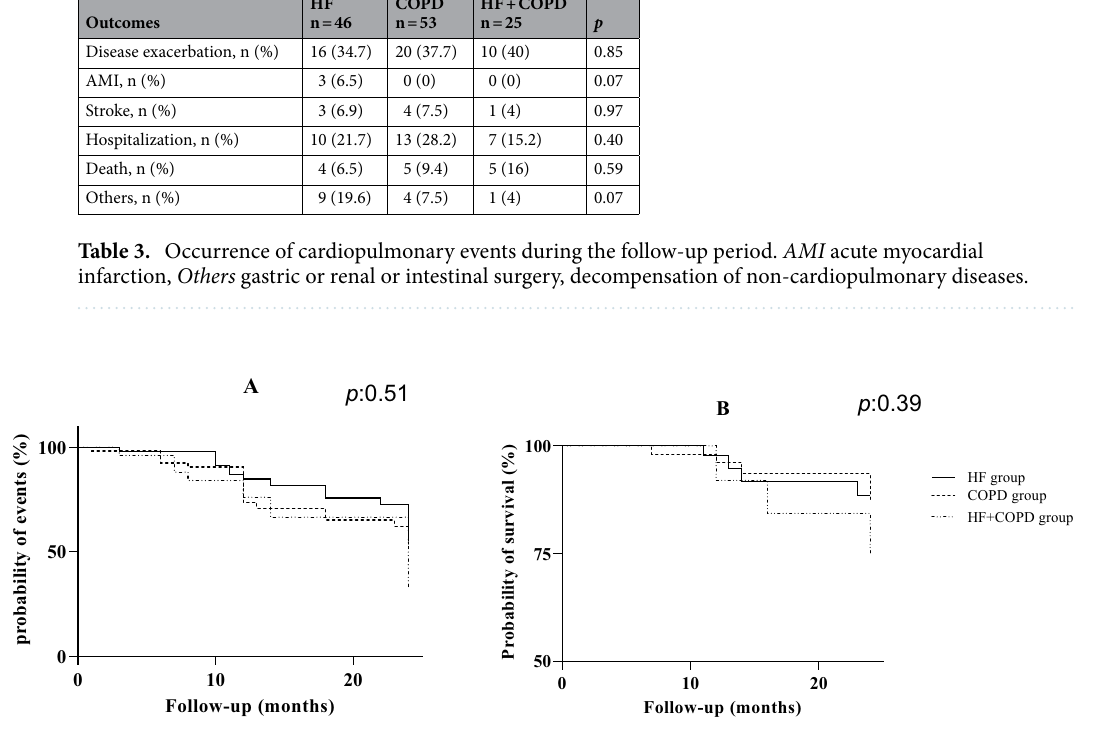
Figure 6. Kaplan–Meier curve. ( A ) Probability of occurrence of cardiopulmonary events; ( B ) probability of survival assessed by occurrence of